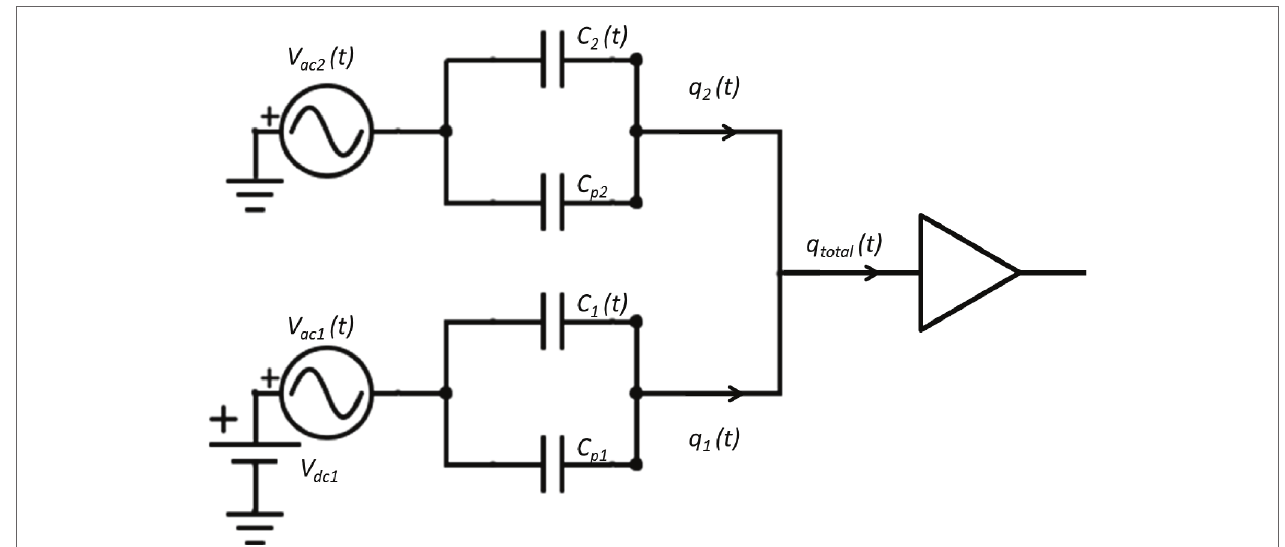
FigUre 4 | schematics of the measurement scheme used for a paired device